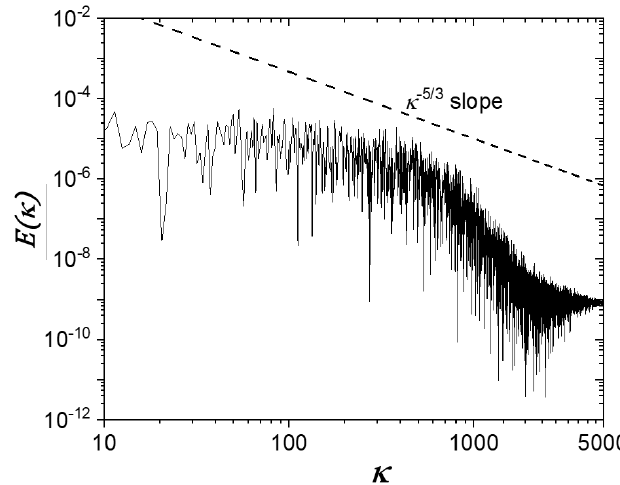
Figure 4. Mean flow fluctuations normalized by friction velocity at Re  = 365.